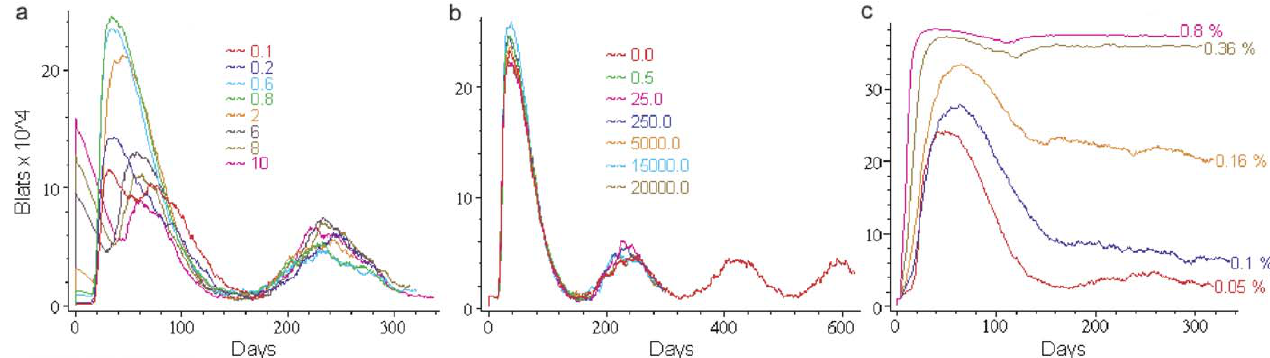
Figure 6. Comparing Simulation Output, Employing the Default Parameter Set, to What Is Known or Expected from a Real Infection (A) Varying the initial infectious dose of Vir has no effect on persistent levels of latently infected virtual B cells (B Lat ). The initial infectious dose is the average number of Vir deposited at each mesh point (node) on the surface of the virtual lymphoepithelium. The simulation was run as described in Figure 4A, except the initial infectious dose of Vir was varied from 0.1 to 10 as shown (the default level is 0.7). Since there are 16,205 surface mesh points, this translates into a total infectious dose ranging from 1.6 3 10 3 to 1.6 3 10 5 . (B) Epithelial cell amplification has no effect on persistent levels of latently infected virtual B cells (B Lat ). Epithelial cell amplification of Vir was simulated by adding an additional amount of Vir at each time step. The virtual amplification achieved varied from none to 2 3 10 4 . (C) Persistence is highly sensitive to the rate of Vir reactivation. The simulation was run as described in Figure 4A, except the percentage of latently infected virtual B cells (B Lat ) that initiate Vir replication upon return to the Waldeyer ring was varied as shown (the default percentage is 0.05% based on data from [16]).